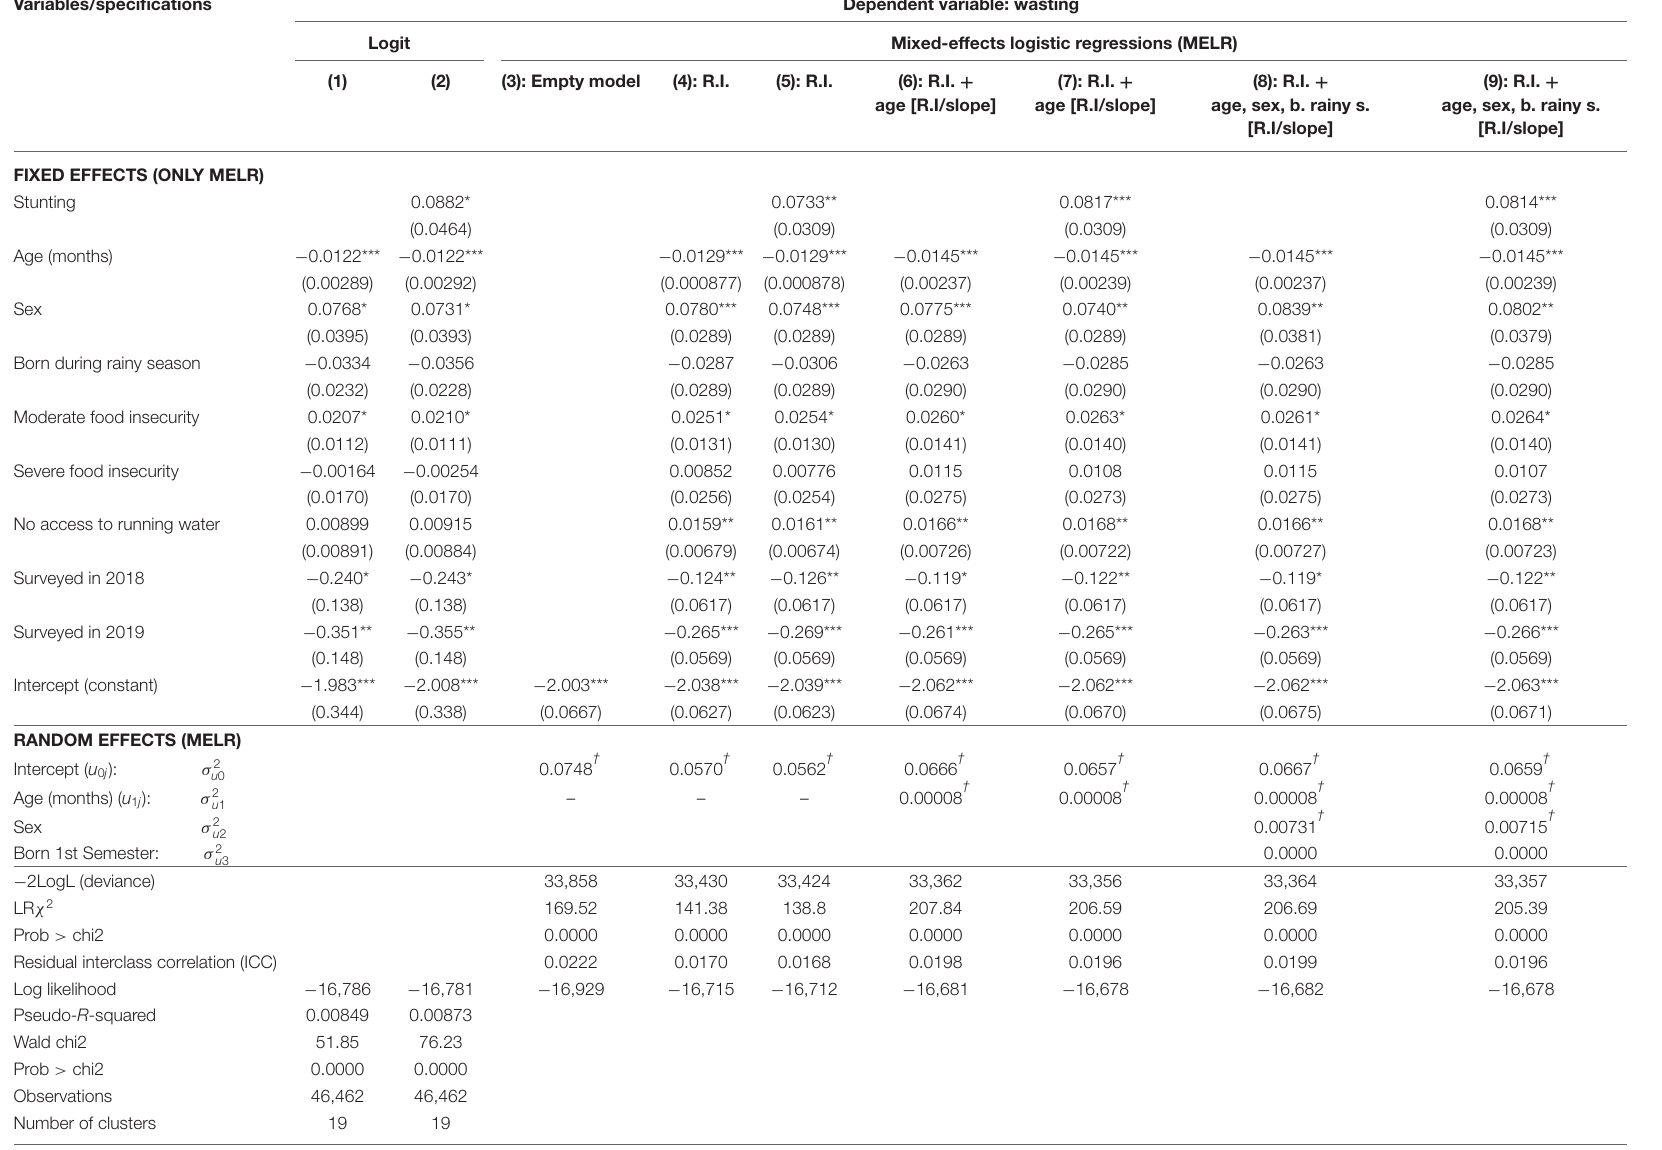
TABLE 6 | Logit and multilevel logistic regression specifications for the probability of being